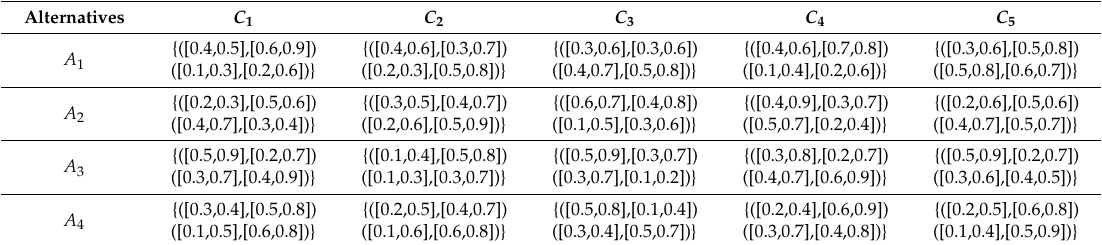
Table 1. The interval-valued intuitionistic hesitant fuzzy decision matrix for decision maker 1.